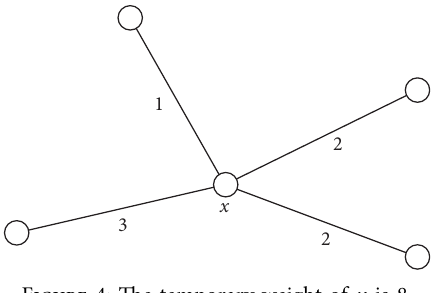
Figure 4: The temporary weight of x is 8.